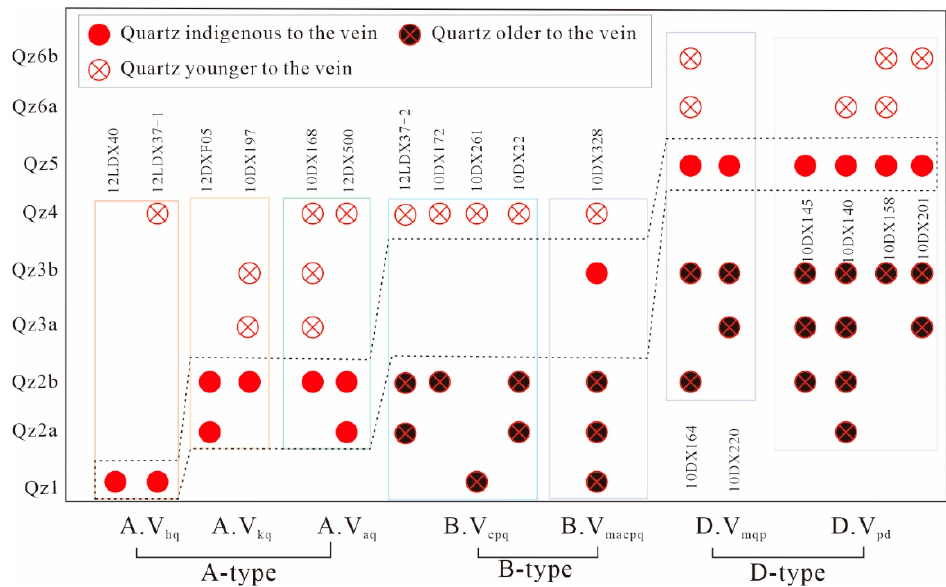
Figure 12. A qualitative estimation diagram of quartz types contained in A-type, B-type, and D-type veins examined in this study. All examined veins (17 in total) contained quartz younger or older than the vein formation, except two A-type veins. All vein contained early quartz (Qz1, Qz2a, and Qz2b), regardless of vein types. The presence of younger quartz in A-type veins indicates low-degree vein reopening, whereas the presence of older quartz in B-type and D-type veins indicates high-degree vein reopening. Note that there were two veins in the sample 12LDX37. The A.V hq vein is named as 12LDX37-1, and the B.V cpq vein is named 12LDX37-2.